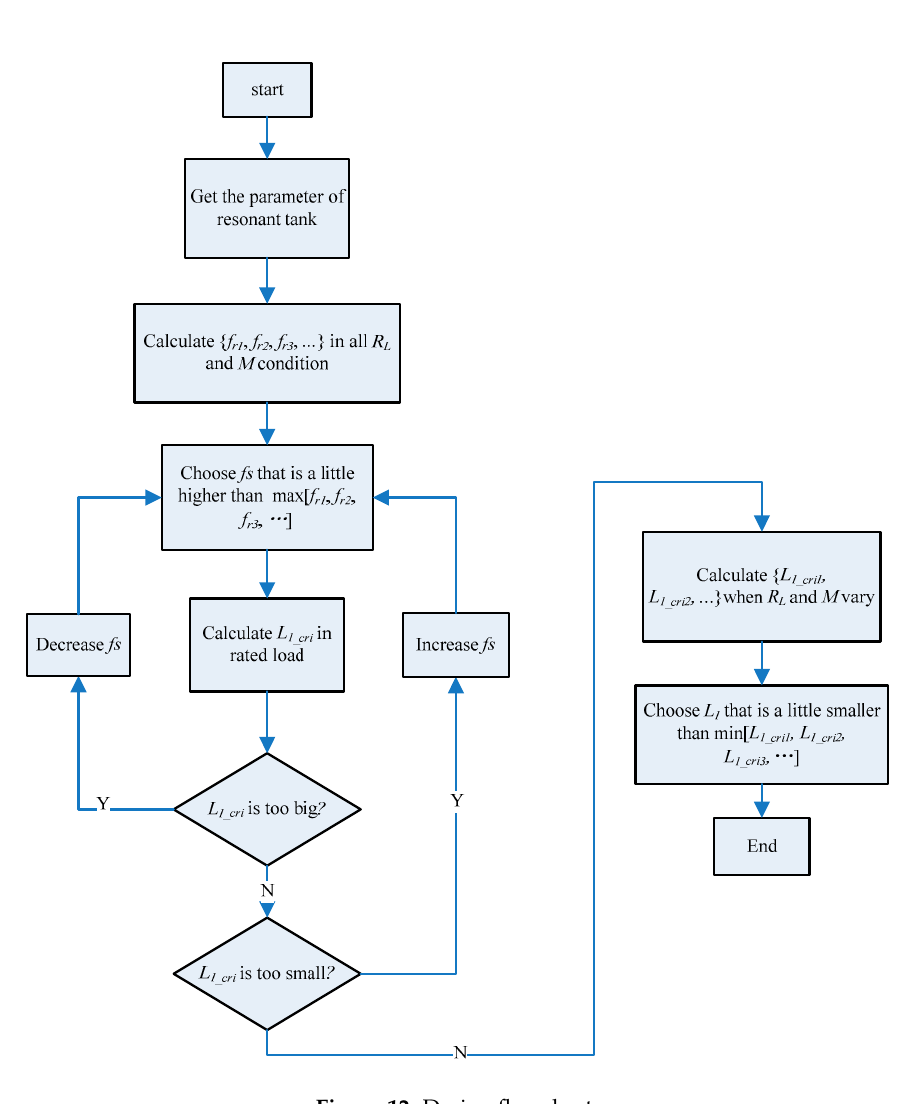
Figure 12. Design flowchart.